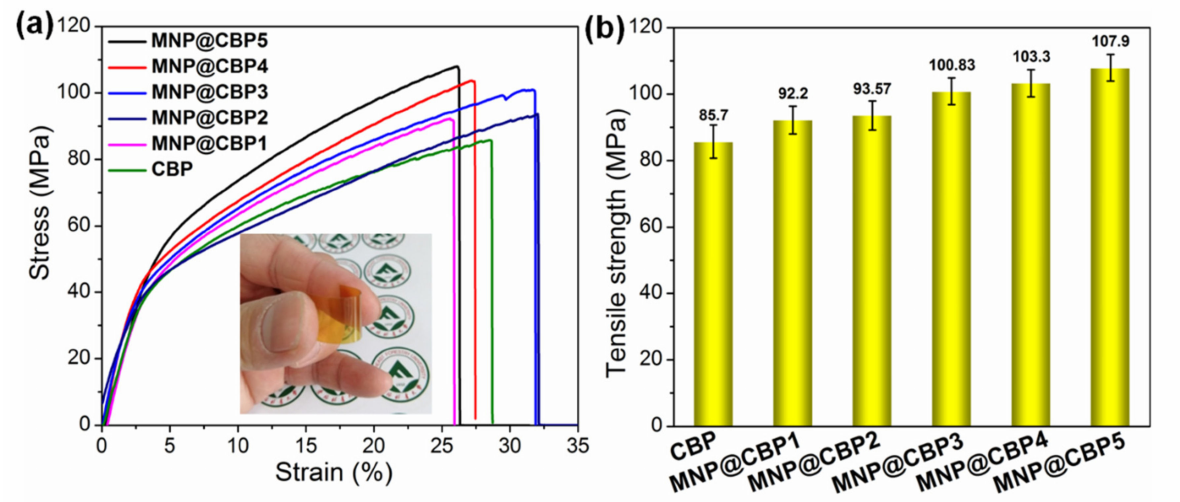
Figure 12. ( a ) Representative stress–strain curves of CBP and MNP@CBPs, ( b ) tensile strength of CBP and MNP@CBPs. The inset is a digital image of the MNP@CBP to show good mechanical robustness and